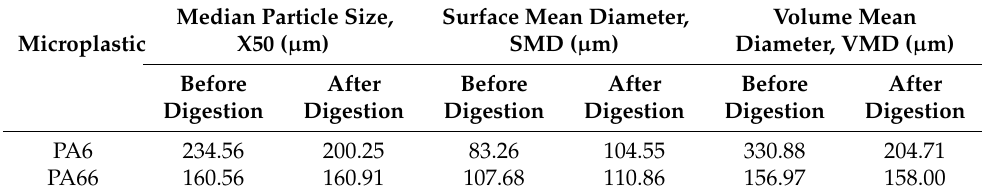
Figure 4. Cumulative particle size distribution of PA6 and PA66 before and after digestion. Table 2. Comparison of particle sizes of PA6 and PA66 before and after digestion.